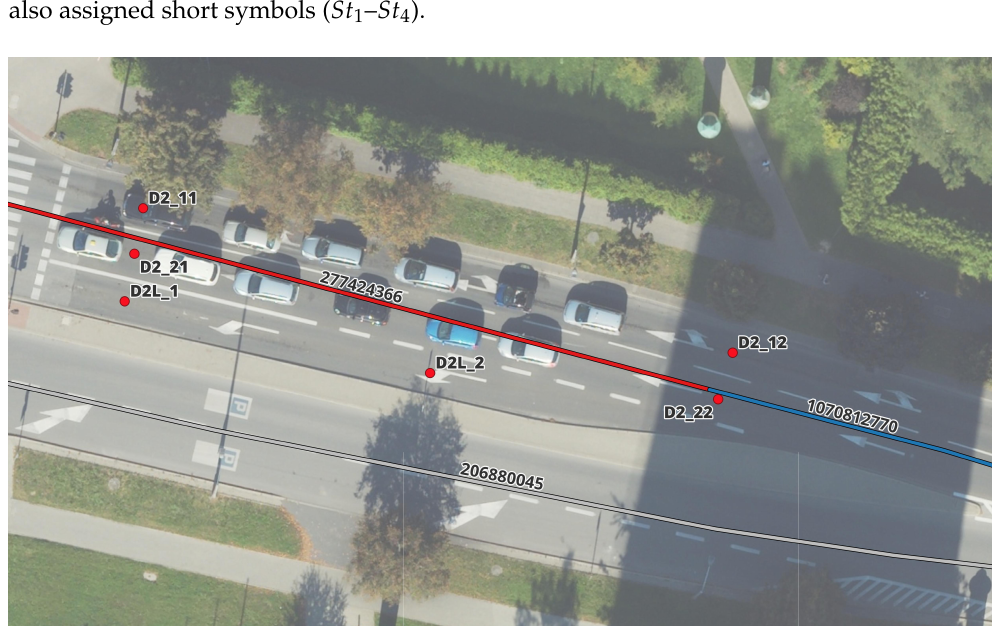
Figure 8. Traffic intensity sensors (points) and traffic data (lines) for an intersection inlet. Table 1. Parameters of OSM ways under